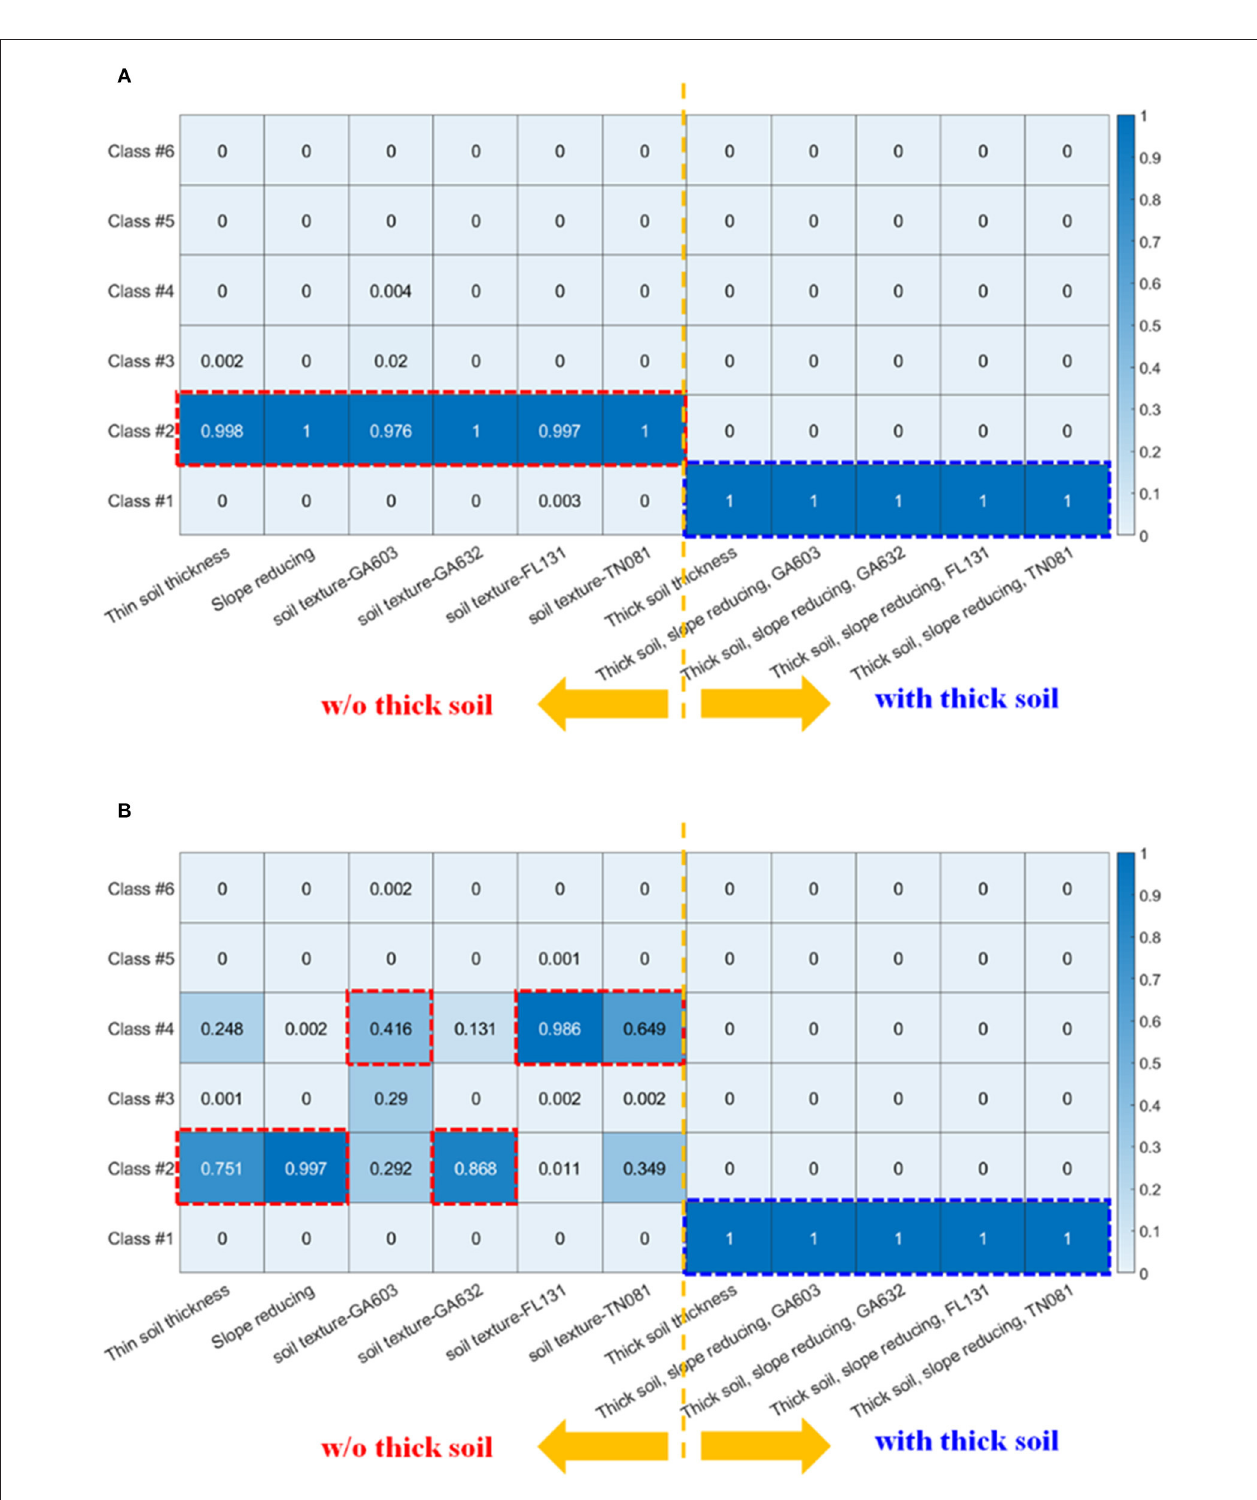
FIGURE 7 | The likelihood function L(y|F) as calculated by GMM in different PAWS + CLM experiments. Deeper blue color highlights higher probability. Here, we only show the (A) OR and (B) PIN subbasins, but the other 2 subbasins have similar results ( Appendix B ).